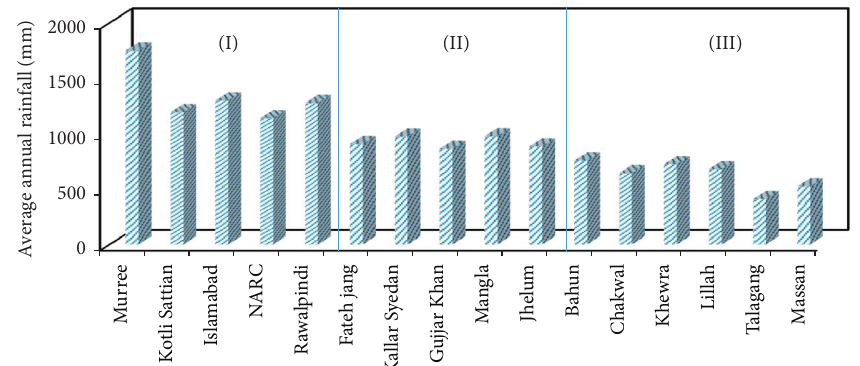
Figure 6: Average annual rainfall comparison of study area stations where classifications (I), (III), and (III) represent (a) zone-1 heavy